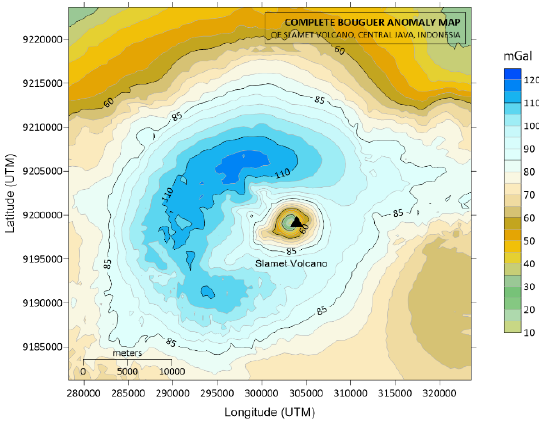
Fig. 6. The complete Bouguer anomalous (CBA) contour map of study area The CBA data still distributed on the topographic need to be projected to a horizontal surface. The equivalent source technique has been applied for this aim by taking the average topographic height of the study area, i.e. 572.58 m. The CBA data that has been spread at the average topographic elevation ranging from 11.889 to 117.429mGal. The CBA data is superposition of regional and local anomalous sources, such that regional and residual anomalies data are separated; since the target of the study is a magma chamber which is a local anomalous source. The separation of regional anomaly data from CBA data was carried out using the upward continuation technique [35], as described in Research Procedure. When the upward continuation is higher, the local anomalous patterns is getting lost and the regional anomalous patterns are getting stronger [36]. The visual analysis of the anomalous contour maps from the upward continuation showed that the anomalous map at an altitude of 30,000 m tended to remain with a smooth pattern. The contour pattern did not change when upward at an altitude of 35,000 m with an accuracy of 0.0001 m. Hence, the anomalies data were taken as regional anomalies data with values ranging from 77.805 to 78.712mGal. The contour map can be seen in Figure 7.